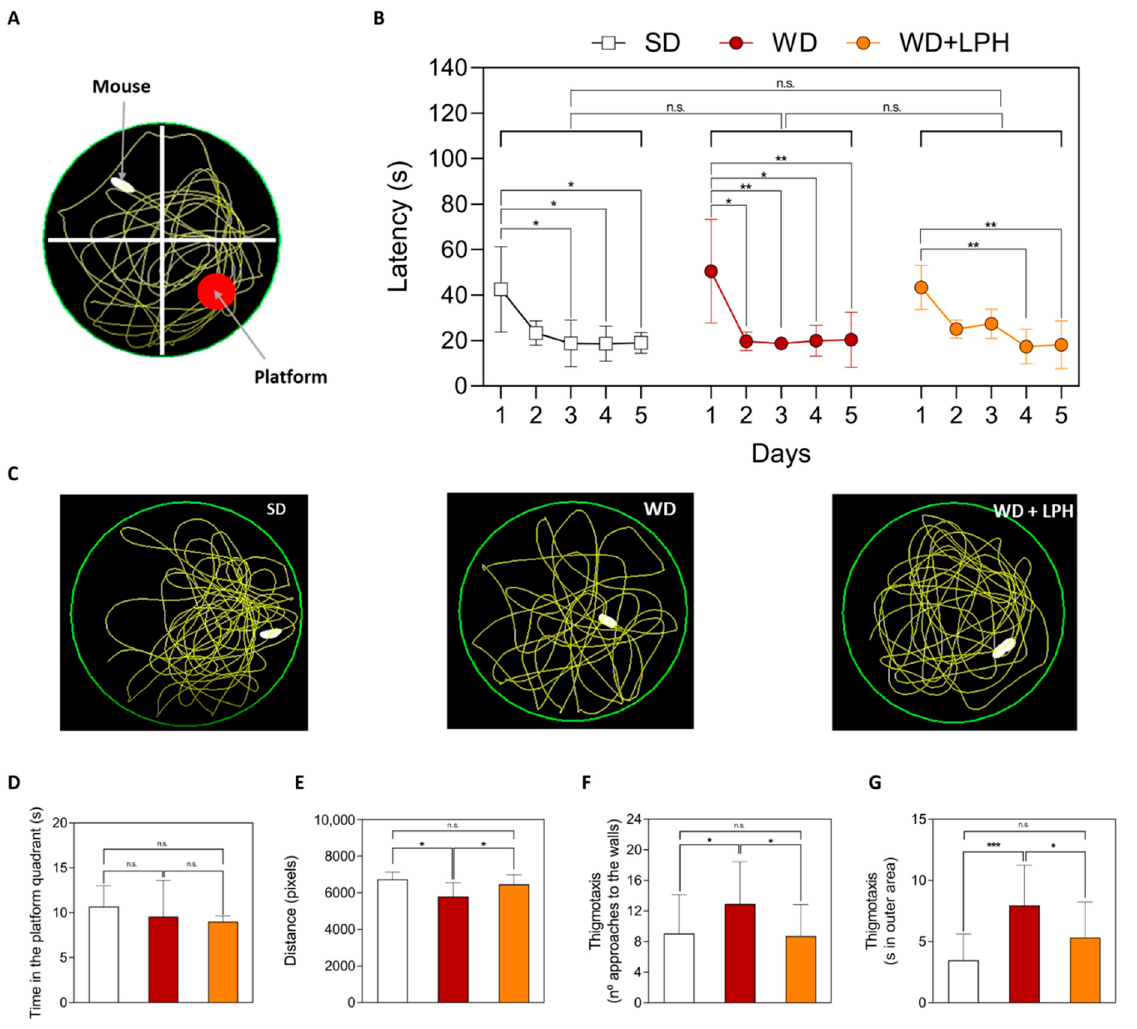
Figure 4. Representative image of the acquisition phase of the Morris water maze ( A ); latency of the mice during the five days ( B ). Representative images of the trial phase ( C ); time in the platform zone ( D ), distance traveled ( E ) and thigmotaxis ( F , G ). Values are shown as the mean and standard deviation of each group. * p ≤ 0.05; ** p ≤ 0.01; *** p ≤ 0.001; n.s., not significant; SD, standard diet-fed mice; WD, Western diet-fed mice; WD + LPH, Western diet-fed mice treated with LPH; LPH, lupine protein hydrolysate.